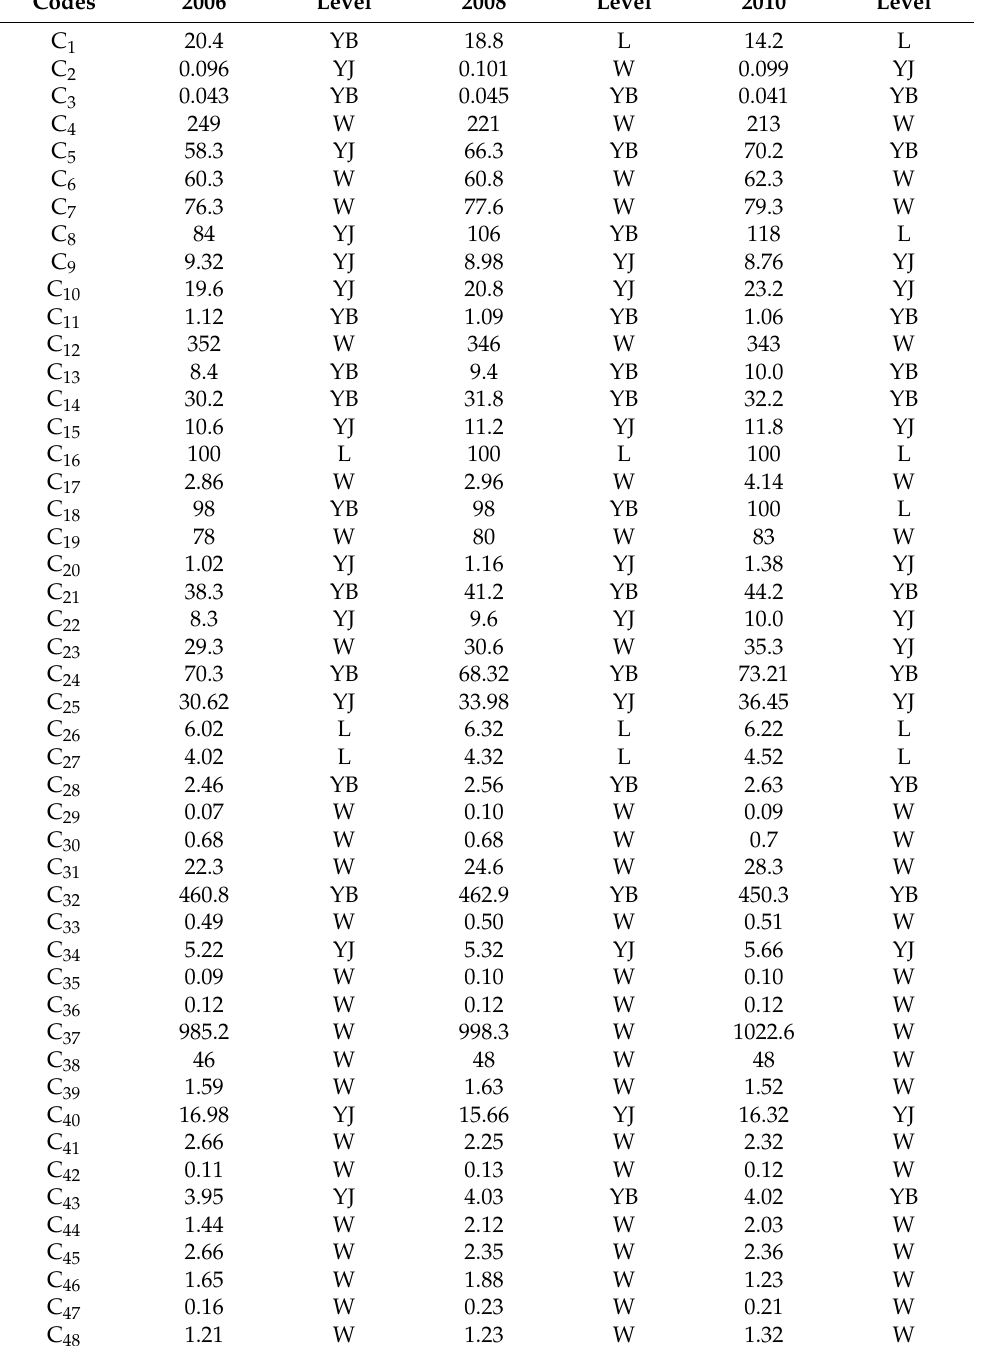
Table A4. The status value and the level of